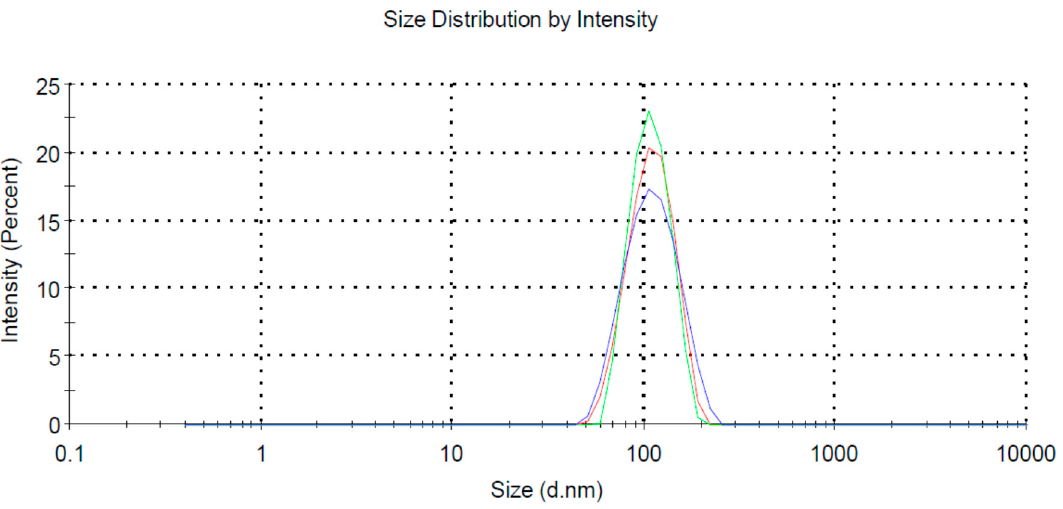
Figure 1. Size distribution of rafted liposomes; three profiles (blue, green and red) stand for three measurements of the same sample.